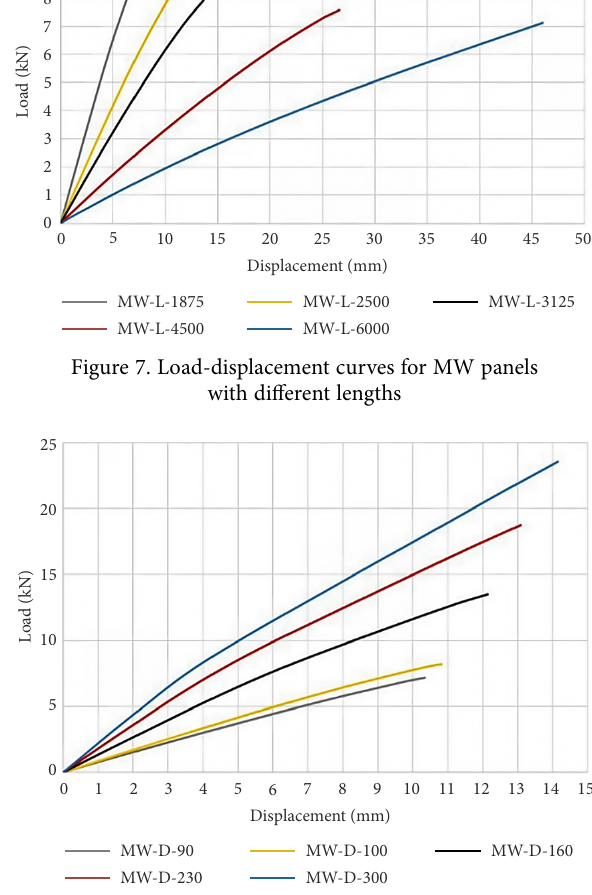
Figure 9. Load-displacement curves for MW panels with different heights